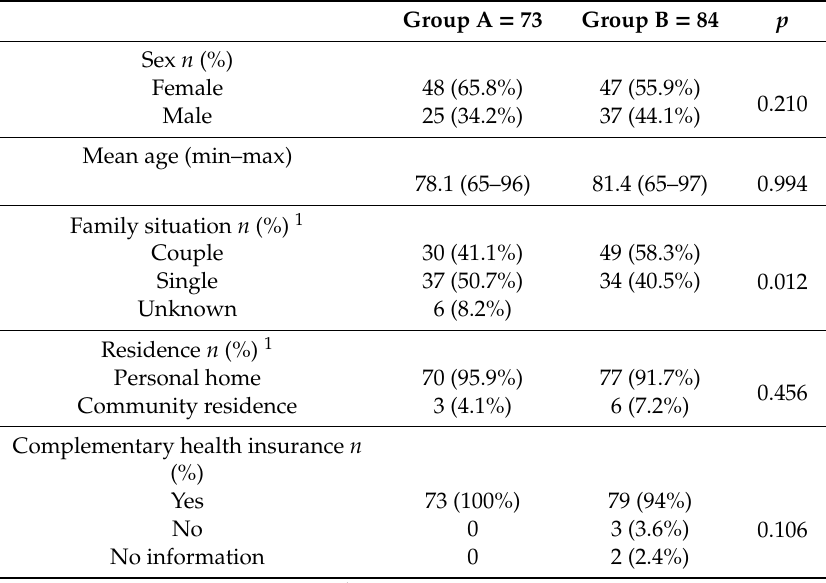
Table 1. Sociodemographic characteristics of patients included in the vaccination during hospitalization (HOSPIVAC)